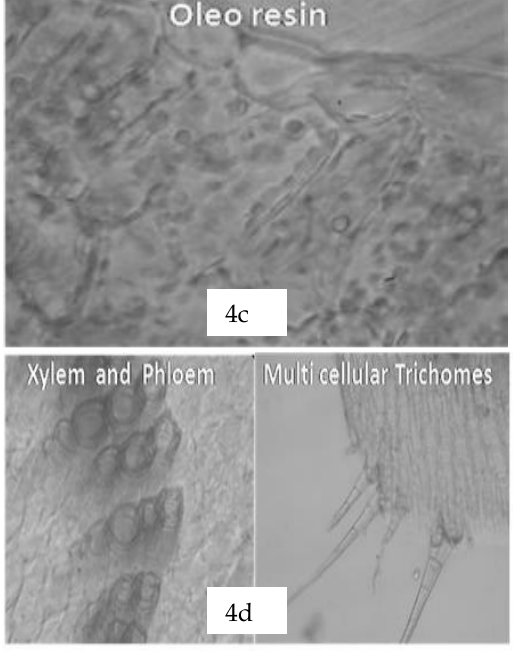
Figure 4: Transverse section of leaf from O. tenuiflorum . Figure 4a represents transverse section of leaf from O. tenuiflorum and Figure 4b, 4c, 4d represents enlarged section of leaf.